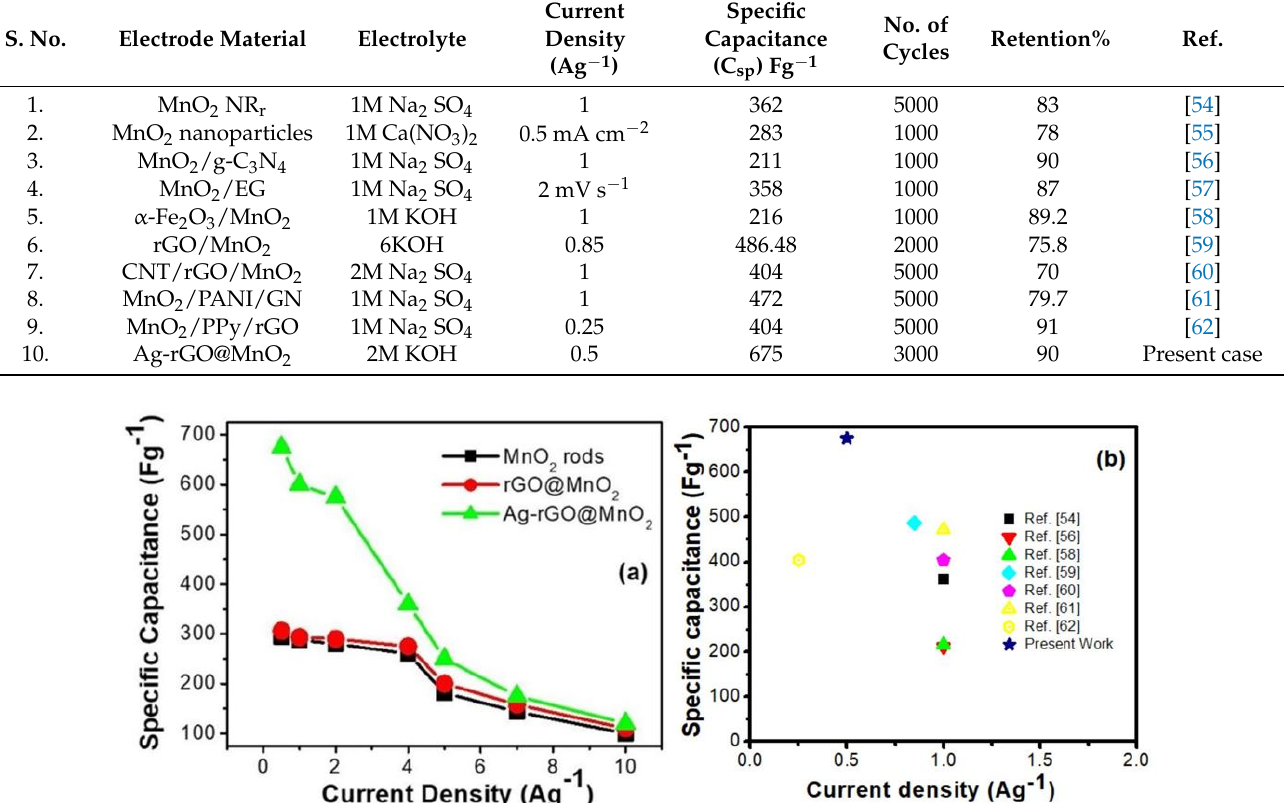
Table 3. The comparative specific capacitance of pure MnO 2 and its composites with the prepared electrode based on Ag-rGO@MnO 2 nanocomposite in previously published papers.